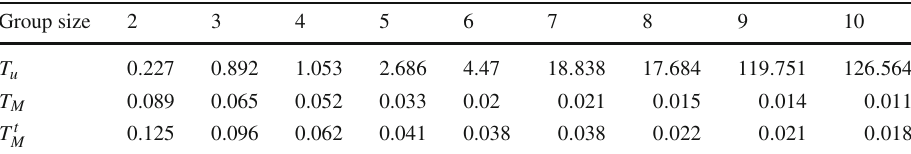
Table 1 Comparison of the MaxSAT transformations T u , T M , and T t M